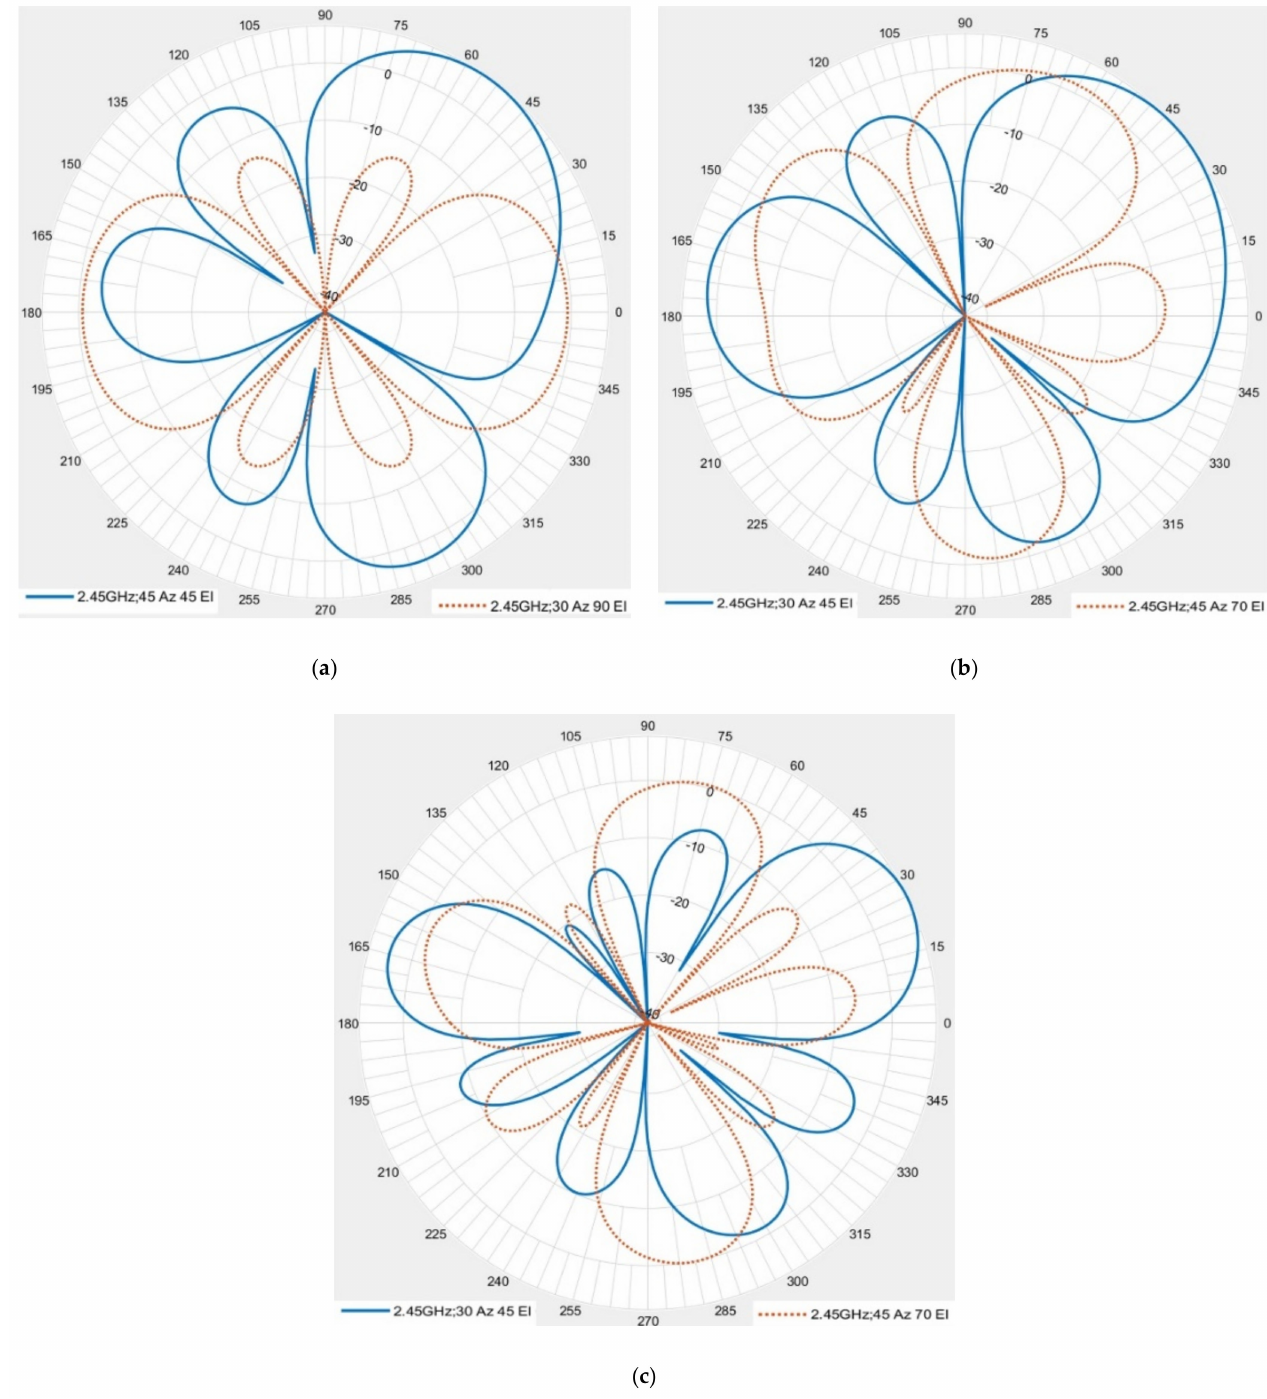
Figure 28. Signal and interference beam-steering for ( a ) case 1 ( b ) case 2 ( c ) case 3. To solve this problem, the number of antenna arrays is increased to 4 × 3 (case